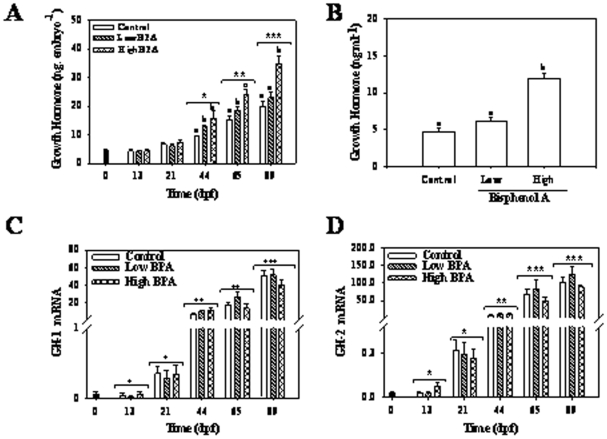
Impact of bisphenol A (BPA) on growth hormone (GH) content and gene expressions.Temporal changes in GH content in the control and BPA treated groups during early development (A) and plasma GH levels at 400-dpf (B); Temporal changes in GH1 (C) and GH2 (D) mRNA abundances in trout exposed to control and two different concentrations of BPA. Maternal transcript levels were measured in freshly fertilized eggs and represented as 0-dpf (dark colored bar). GH was determined using trout specific anti-GH antibody as described in the materials and methods. Two-way ANOVA was used to determine the effect of time, treatment and interaction effects on GH levels and transcript levels during development (Bonferonni posthoc test; p<0.05). Different letters represent differences between treatments at each time point. Asterisk (*) represent effect of time on GH content. One way ANOVA was used to determine the effect of BPA on plasma GH levels. All values represent mean + SEM (n = 7).